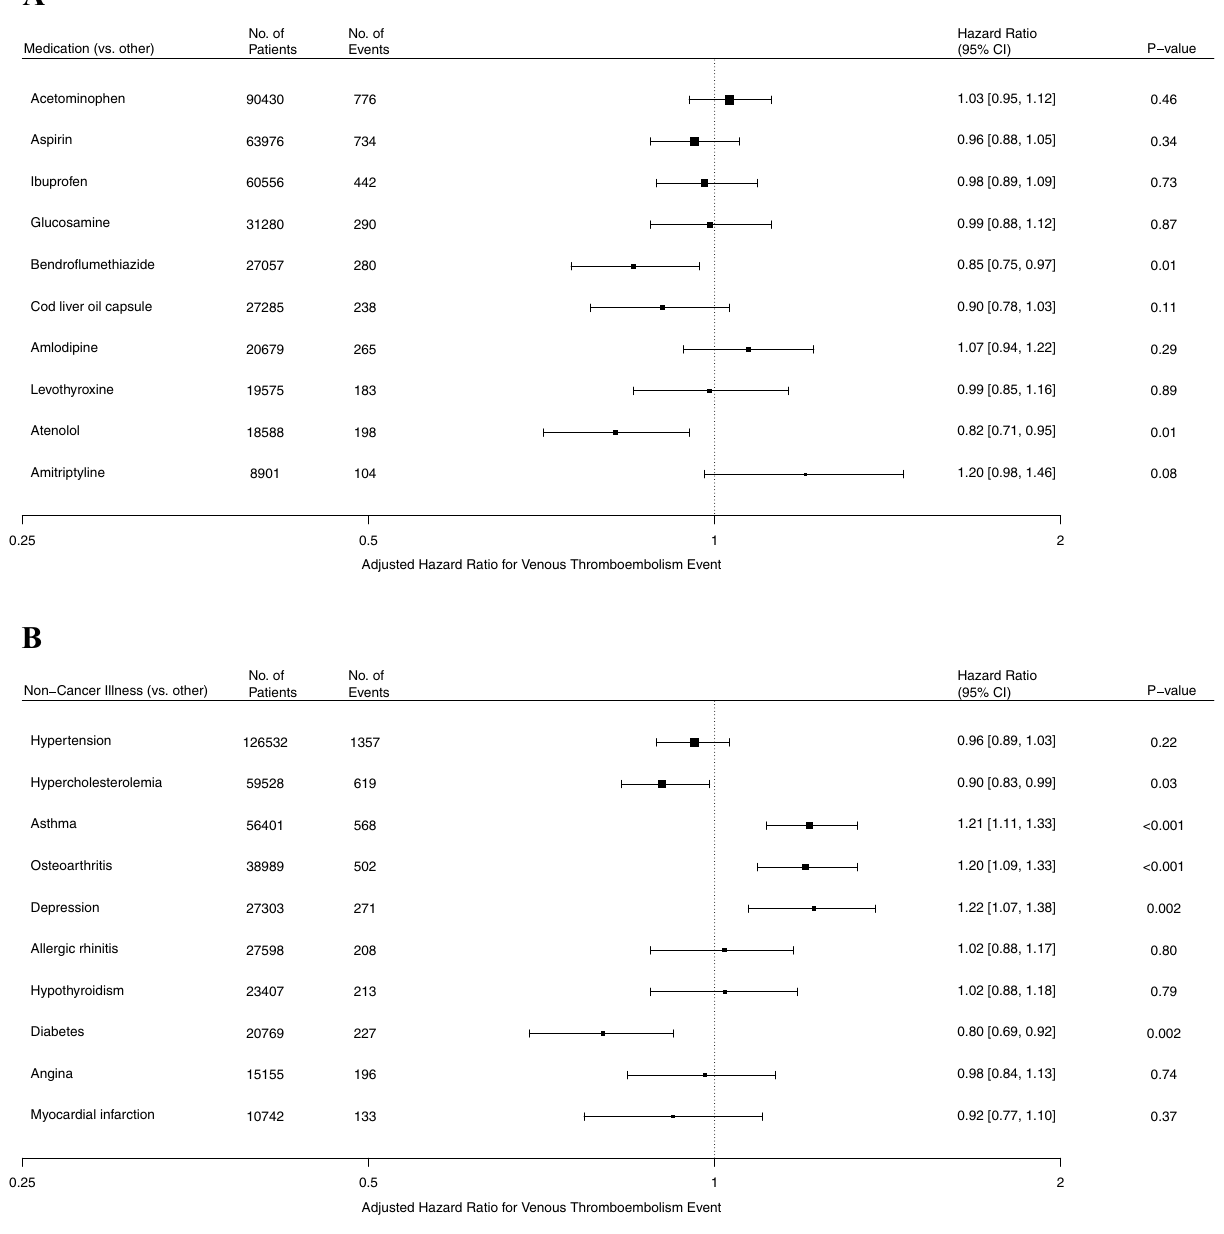
Figure 2. Adjusted hazard ratios for primary venous thromboembolism for common medications and non- cancer illnesses. Shown are the adjusted hazard ratios for primary venous thromboembolic events for two factors of interest: common medications ( A ) and non-cancer illnesses ( B ). All estimates were adjusted for all nine established risk factors and the first four principal components of ancestry. The I bars represent 95% confidence